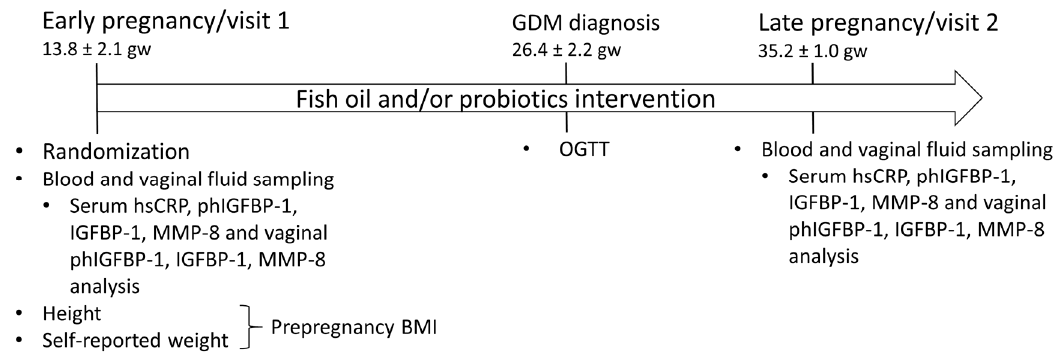
Figure 2. Timeline of the study. gw, gestational weeks; hsCRP, high ‐ sensitivity C ‐ reactive protein; phIGFBP ‐ 1, phosphor ‐ ylated insulin ‐ like growth factor binding ‐ protein 1; MMP ‐ 8, matrix metalloproteinase 8; BMI, body mass index; OGTT, oral glucose tolerance test.